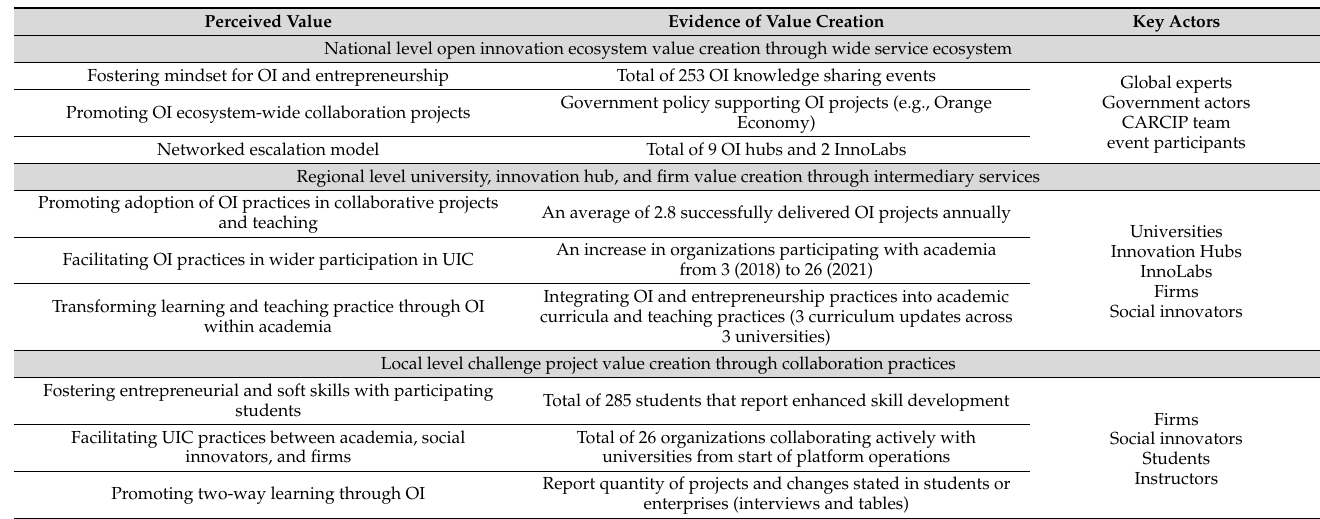
Table 1. Perceptions of value